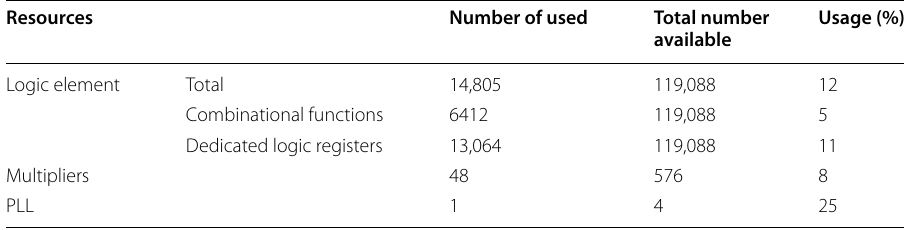
Table 2 FPGA Usage